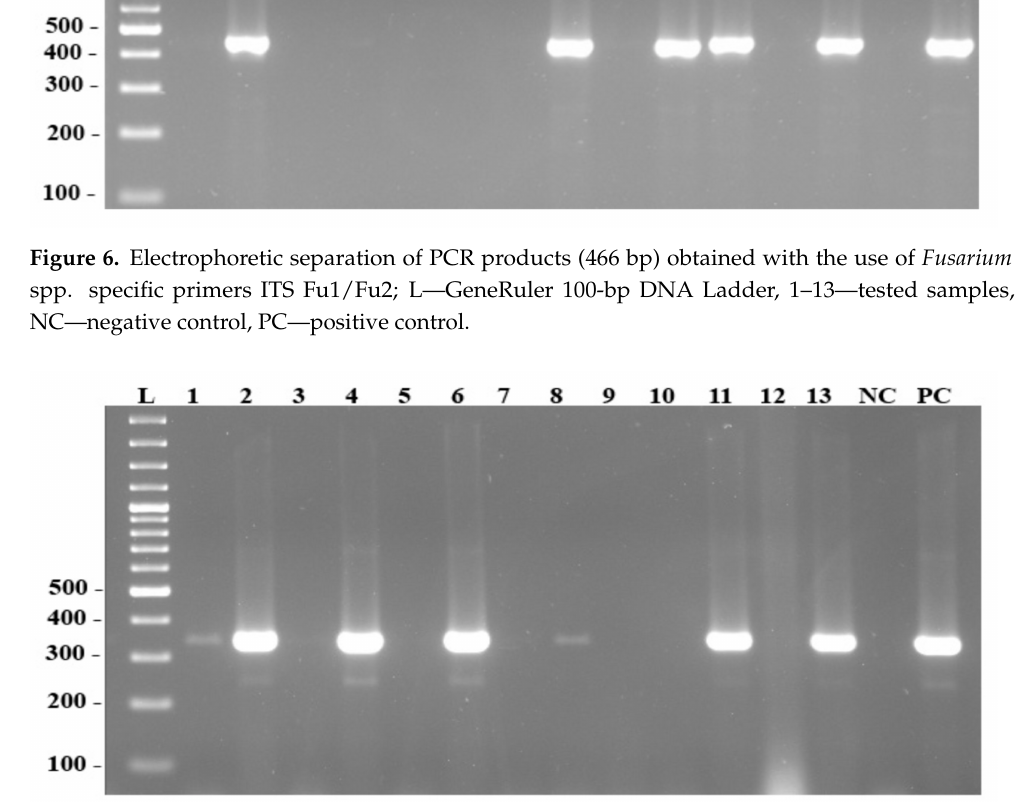
Figure 7. Electrophoretic separation of PCR products (340 bp) obtained with the use of Fof1/Fof2 primers specific for F. oxysporum ; L—GeneRuler 100-bp DNA Ladder, 1–13—tested samples, NC—negative control, PC—positive